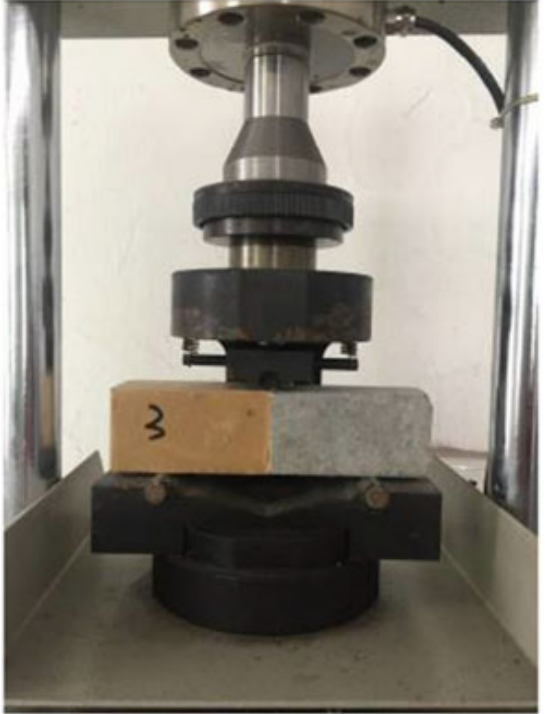
Figure 4. Tests for flexural bond strength between repair materials and concrete substrate [59]. (Adapted and reprinted with permission from ref. [59], © 2018, Construction and Building Materials .).